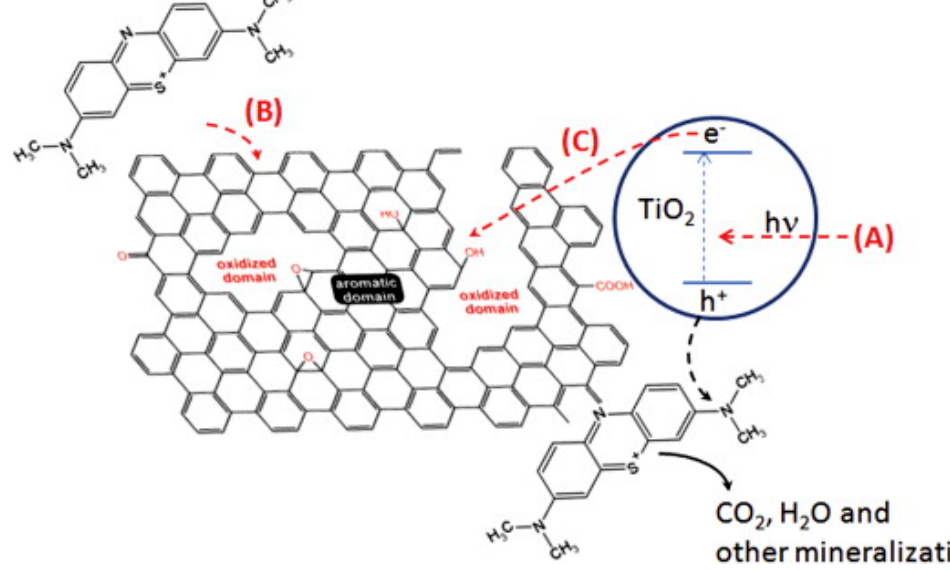
Figure 4. TiO 2 /GO nanocomposites and mechanisms of MB photo-decomposition (A) light absorption (B) dye adsorption (C) electron transfer and charge separation. The improvement in degradation is due to dye-TiO 2 /GO hydrophobic and dipolar interactions and increased photogenerated electrons-positive holes lifetime. Reprinted with permission from reference [72]. Copyright 2011 Elsevier.